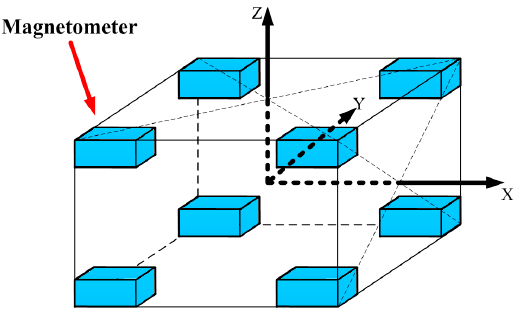
Figure 1. Structure of the magnetometer array to implement the STAR method.